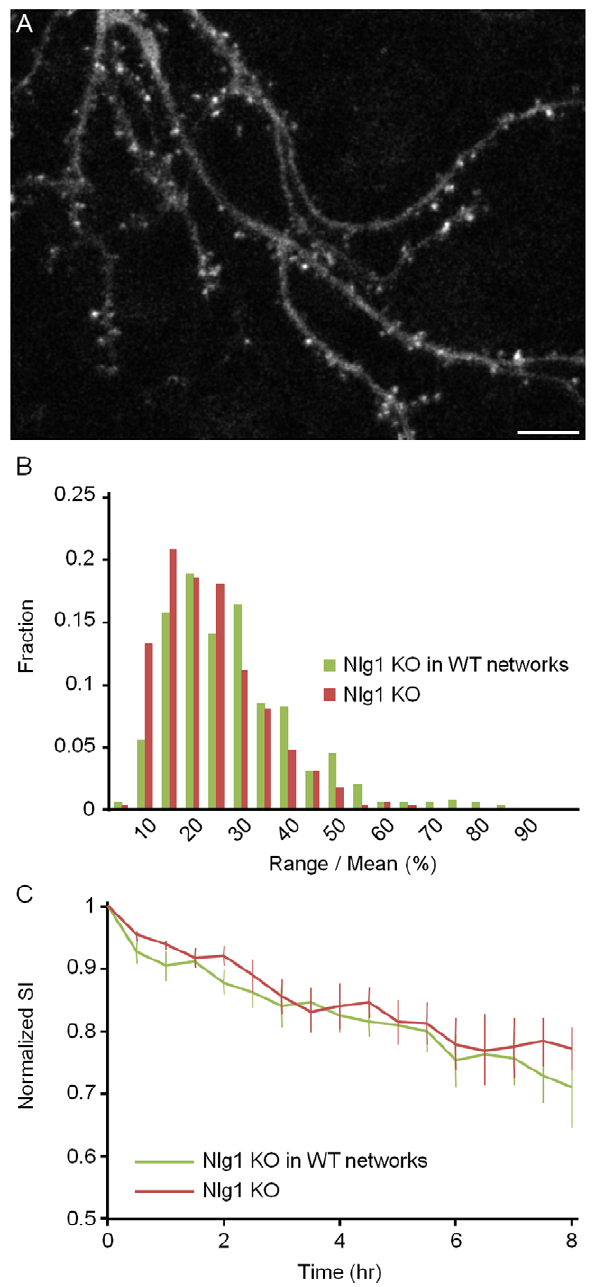
Figure 7. AMPAR redistribution dynamics of Nlgn-1 deficient neurons in a WT environment. A ) A cortical neuron expressing SEpH:GluA2 from a Nlgn-1 KO mouse plated in a network in which the majority of cells were obtained from a WT littermate. 23 days in vitro . Bar, 10 m m. B ) Distribution of range over mean values for all SEpH:GluA2 puncta followed in these experiments (Nlgn-1 KO neurons in WT neuronal networks: 6 neurons, 563 synapses; Nlgn-1 KO networks: 6 neurons, 652 synapses). C ) SI decay rates (mean 6